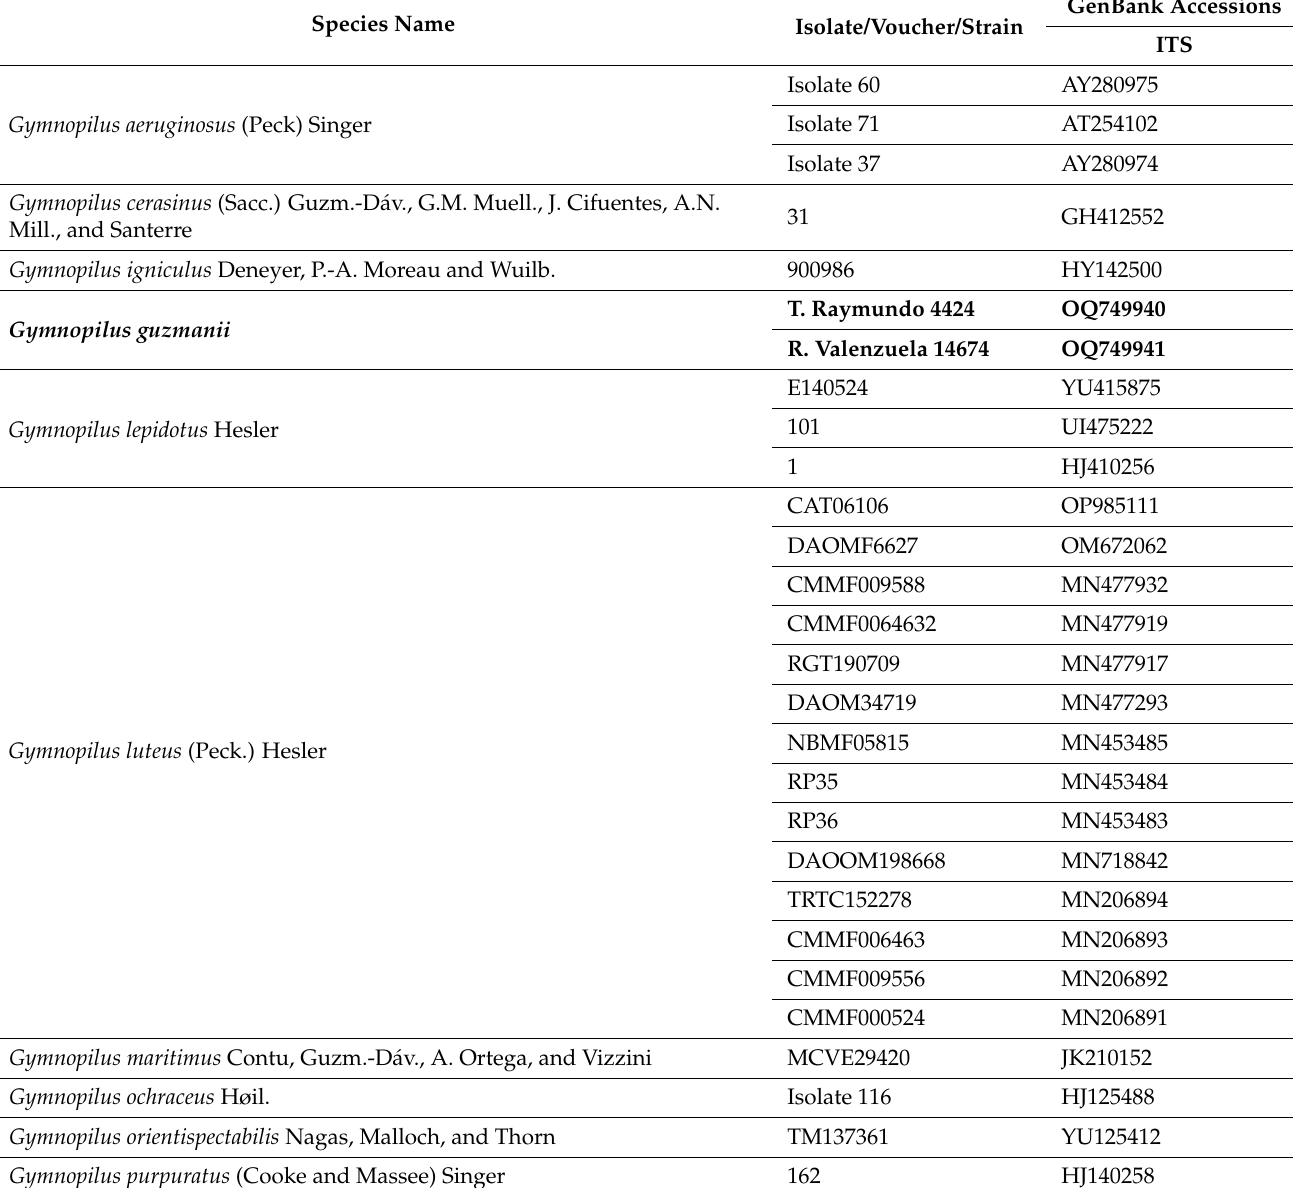
Table 2. GenbBank accessions corresponding to the Gymnopilus sequences used in the phylogenetic analyses. In bold, the accessions of the new species. Species in bold correspond to the new